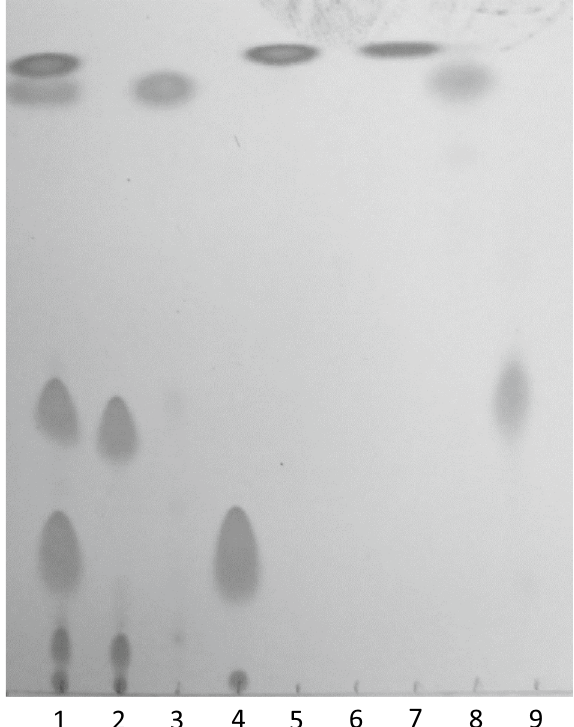
Figure 6. Thin layer chromatogram of human skin swab extract fractionated on a normal phase silica gel plate. Lane assignments are as follows: 1—All standards (trilinolein [20 µg], jojoba oil [20 µg], linoleic acid [20 µg], squalene [10 µg]), 2—trilinolein (20 µg), 3—jojoba oil (20 µg), 4—linoleic acid (20 µg), 5—squalene (10 µg), 6— blank, 7—hexane fraction (0.1 BE), 8—2% ether (in hexane) fraction (0.1 BE), 9—5% ether (in hexane) fraction (0.1